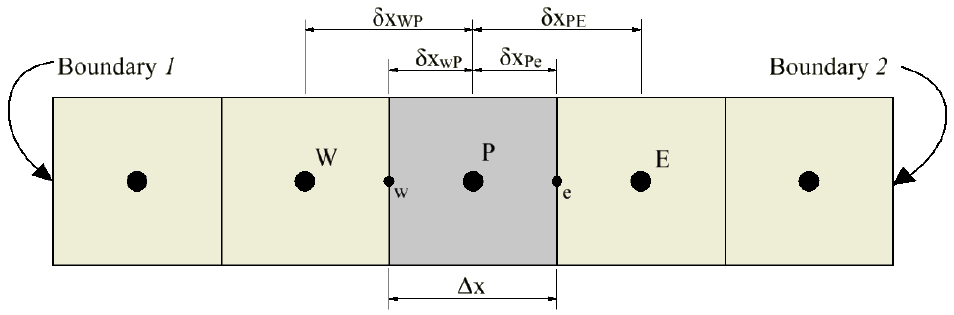
Figure 5. Control volume used in the discretization.